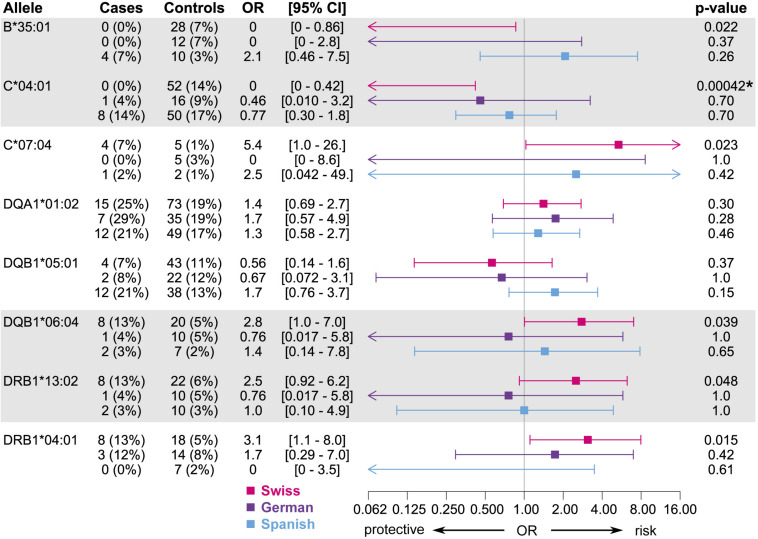
Associations of candidate alleles from the discovery subset at two-field resolution in the three independent cohorts, where cases are restricted to those meeting the criterion for agranulocytosis. HLA typing results obtained by HTS were used if available, else typing results obtained by HLA imputation were used. Alleles in strong linkage disequilibrium are highlighted in one contiguous gray block. All p-values < 0.01 are highlighted with an asterisk.